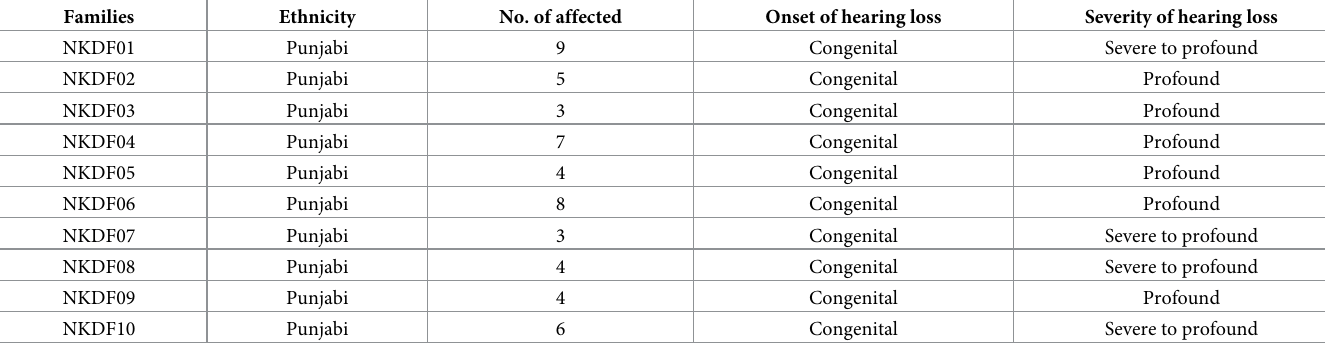
Table 1. Clinical manifestation in families subjected to GJB2 sequence